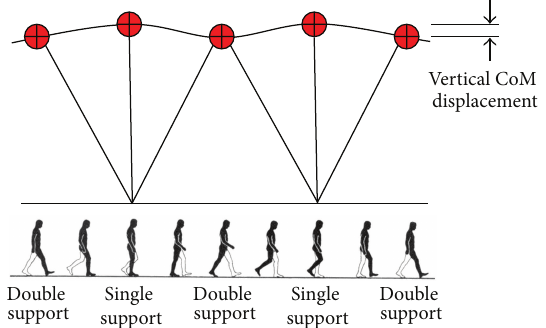
Figure 2: Inverted pendulum model of gait, showing how the center of body mass (CoM) rises during the single support and falls during the double